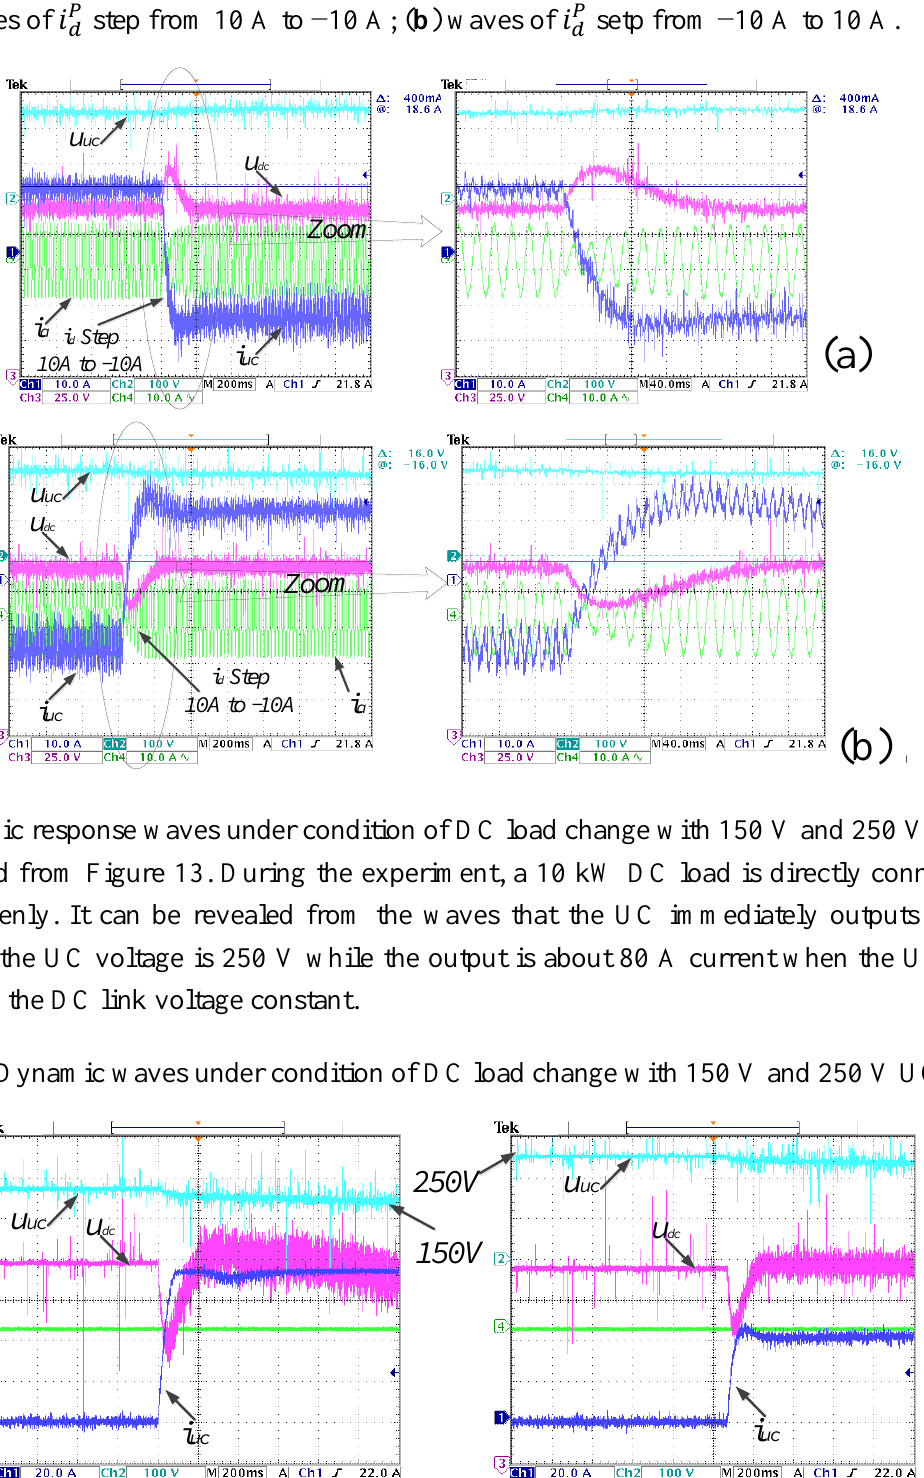
Figure 12. Dynamic waves under condition of AC load change with 250 V UC voltage: